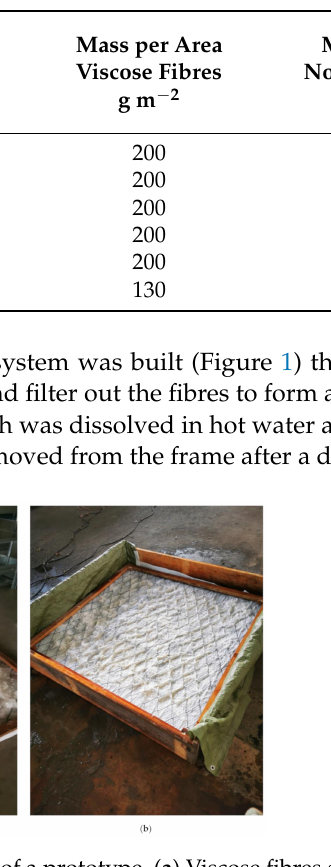
Figure 1. Preparation of a prototype, ( a ) Viscose fibres are distributed randomly on the steel mesh, underneath there is a viscose fleece, ( b ) prototype after wet-laying